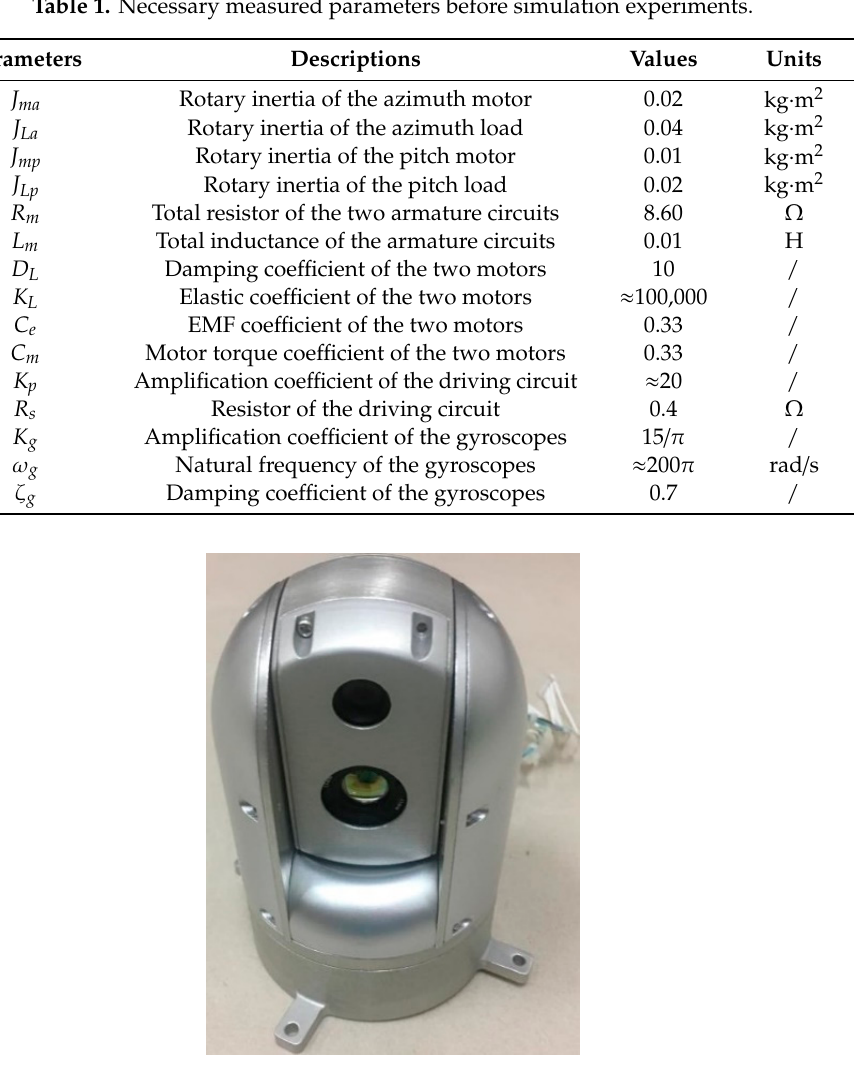
Figure 14. Overall simulation modeling of the system stability accuracy. Table 1. Necessary measured parameters before simulation experiments.